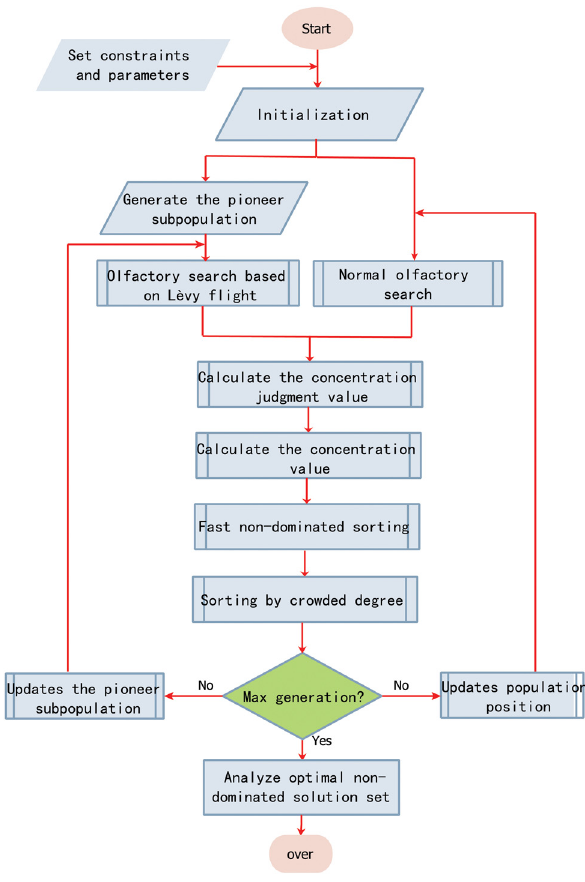
Figure 4: The search area of the improved fruit fl y algorithm. Figure 5: Planning strategy fl